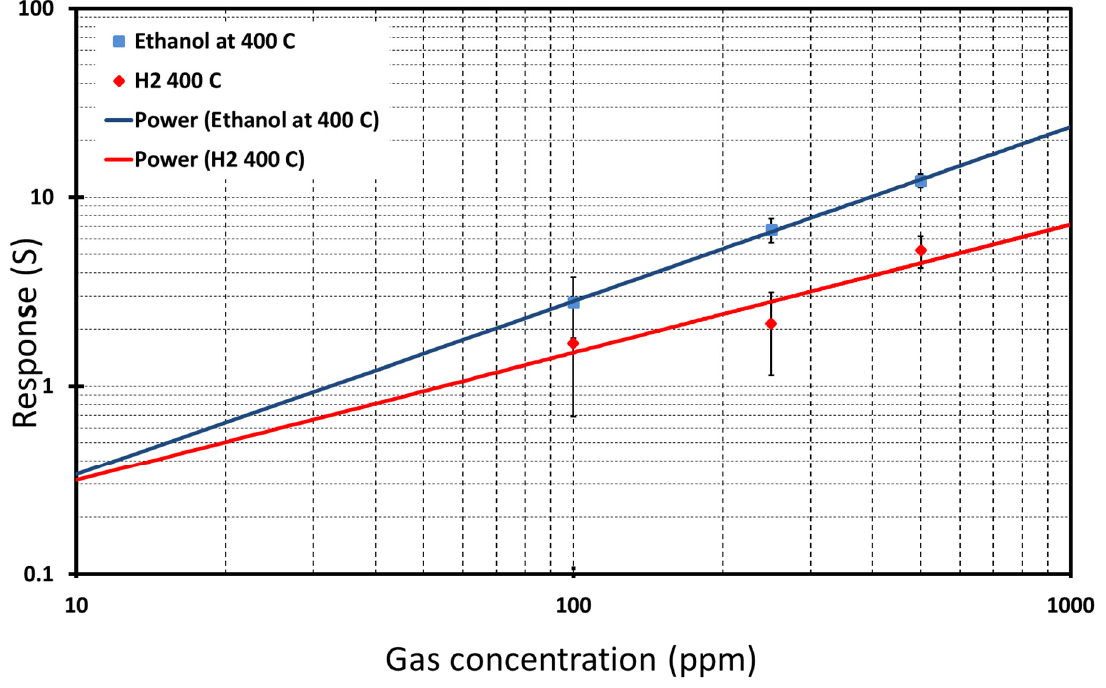
Figure 12. Calibration curves of TiO 2 NWs reporting the response versus gas concentration at optimal temperatures and relative humidity of 40% at 20 °C. Table 2. Power law calibration coefficients and detection limits of TiO 2 for ethanol and H 2 at optimal working temperatures of 400 °C.